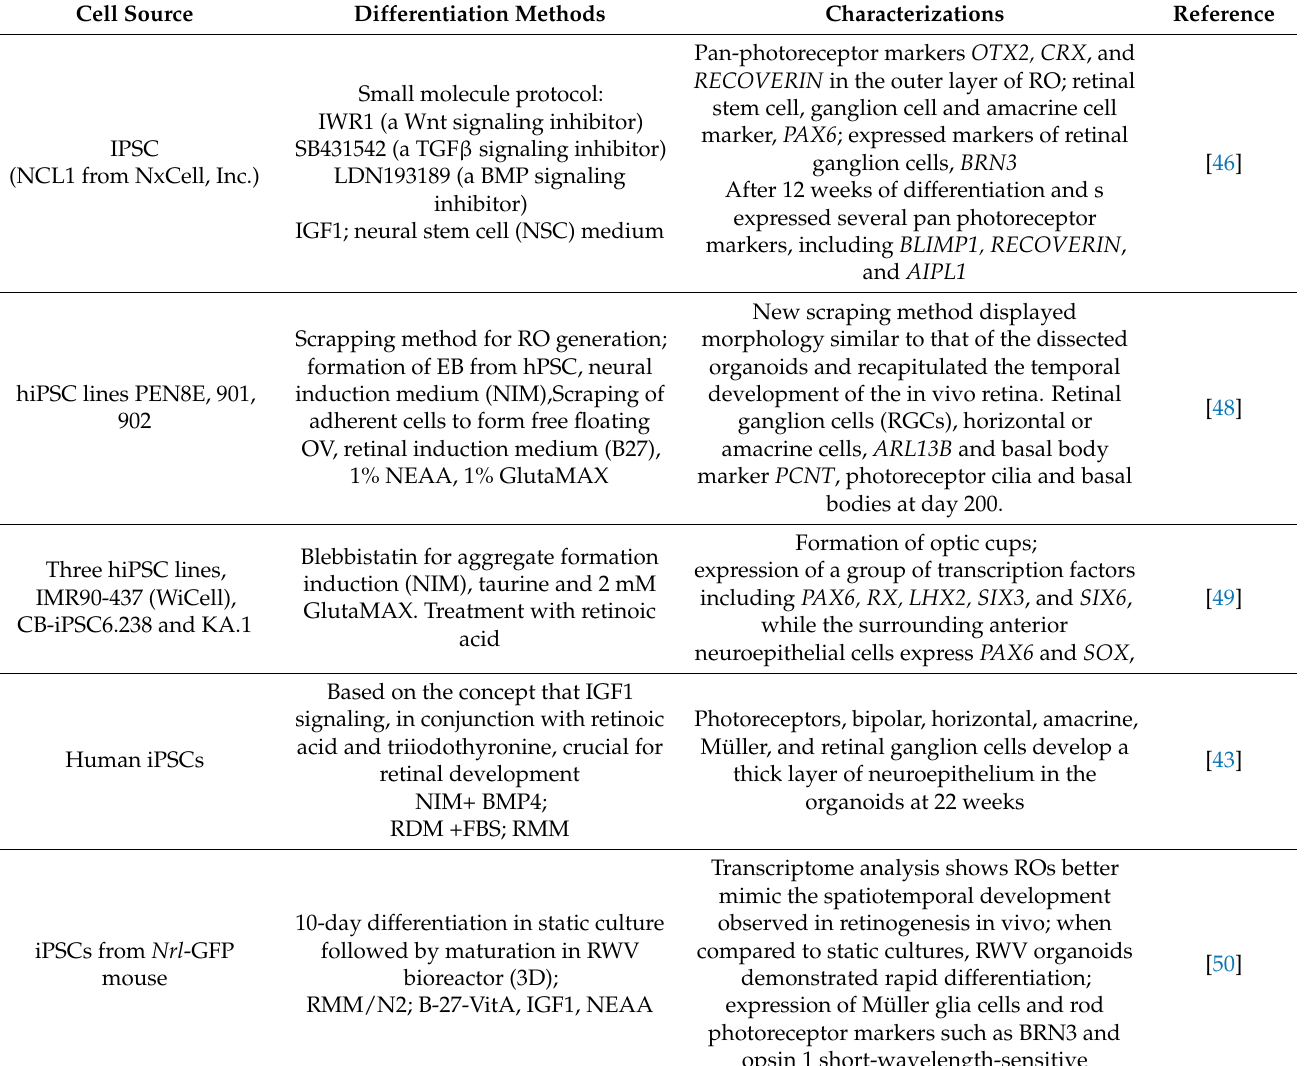
Table 1. Summary of differentiation protocols for hPSC-derived retinal